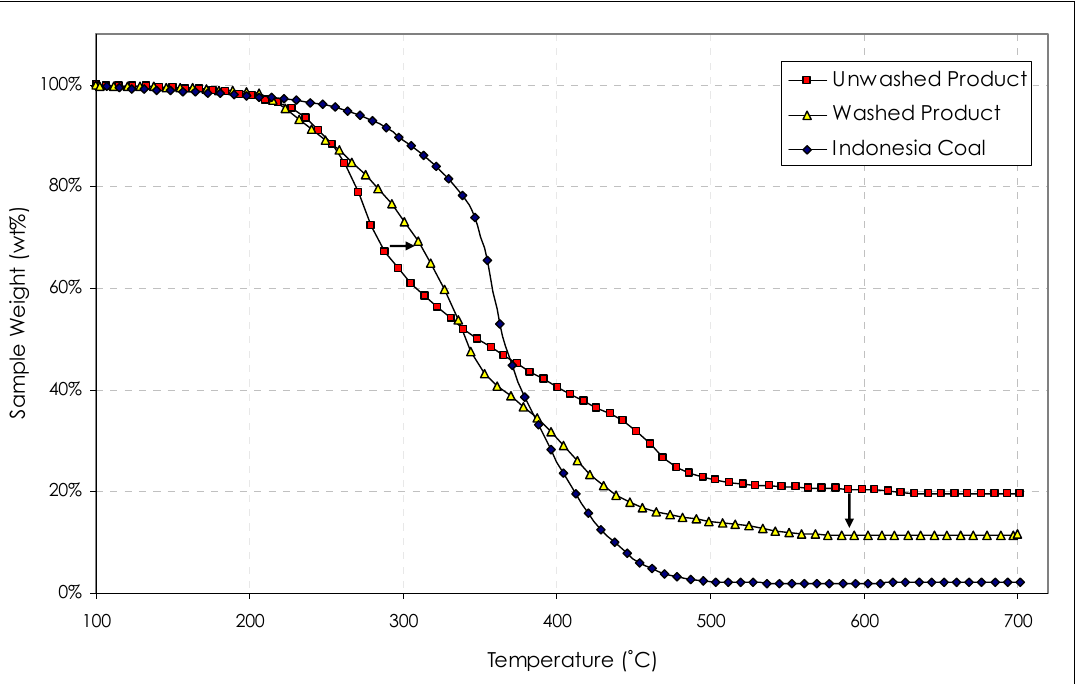
Figure 11. TG profiles of the hydrothermally treated products before and after the washing